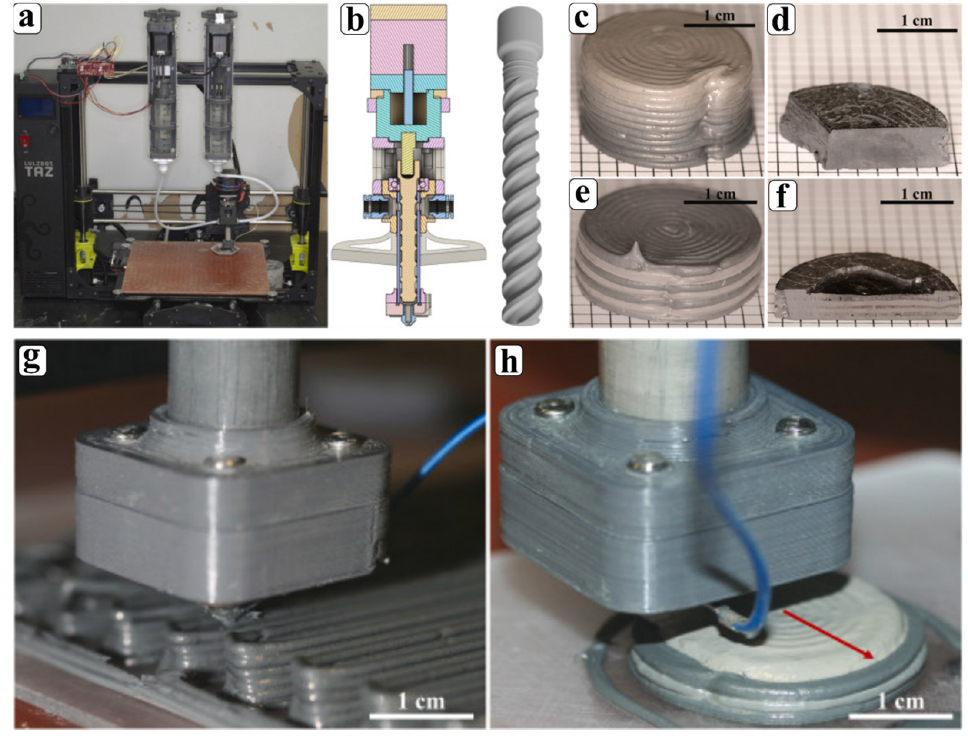
Figure 8. ( a ) DIW system mounted on LulzBot 6 printer, ( b ) cross-section of the extrusion head, ( c ) continuous gradient printing in green states, ( d ) sintered states, ( e ) a sharp transition pattern of ceramic carbide specimen in green state, ( f ) in sintered state; light and dark inks are SiC and B 4 C, respectively, ( g ) deposited B 4 C ink stacks indicate good shape retention, ( h ) inside-out concentric infill patterns were found to reduce printing related defects over rectilinear infill patterns. All images reproduced with permission, Copyright © 2021 [80].